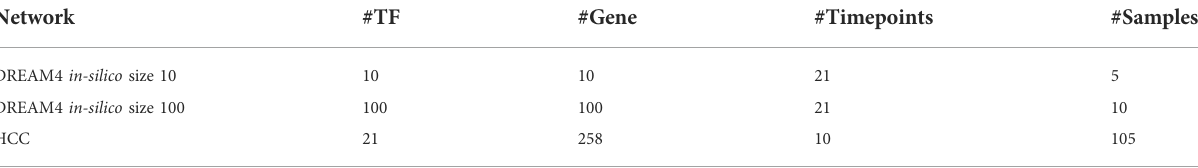
TABLE 1 The dscription of the datasets used in the experiments. Network